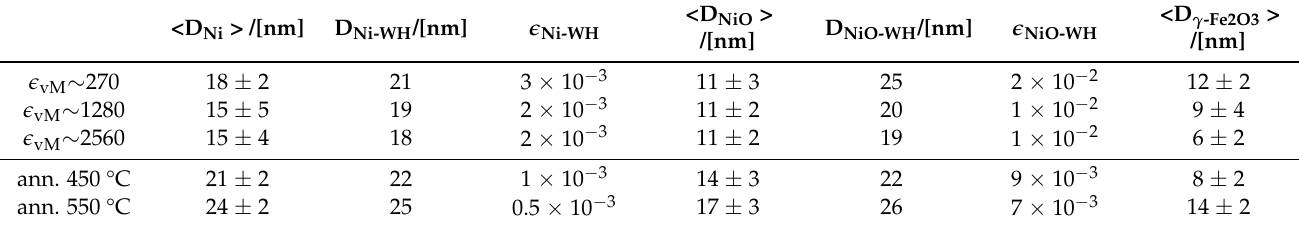
Figure 4. Synchrotron WAXS results are shown for different applied strains of the Fe 10 Ni 40 NiO 50 sample. Starting from bottom: (cid:101) vM ∼ 270, (cid:101) vM ∼ 1280 and (cid:101) vM ∼ 2560. The two annealed samples are at the top: atop the sample annealed at 550 °C and below the sample annealed at 450 °C. At low q-values the development of γ -Fe 2 O 3 peaks were visible. γ -Fe 2 O 3 -peaks became weaker with high applied strains due to a reduction of CSDS. Table 2. A summary of integral peak breadth analysis is shown, which was done for the Fe 10 Ni 40 NiO 50 sample deformed at T def = 300 °C. <D x > is the average crystallite size or CSDS, D x-WH represents the strain-less CSDS result and (cid:101) x-WH residual strain in the crystallite both values were obtained by the WH